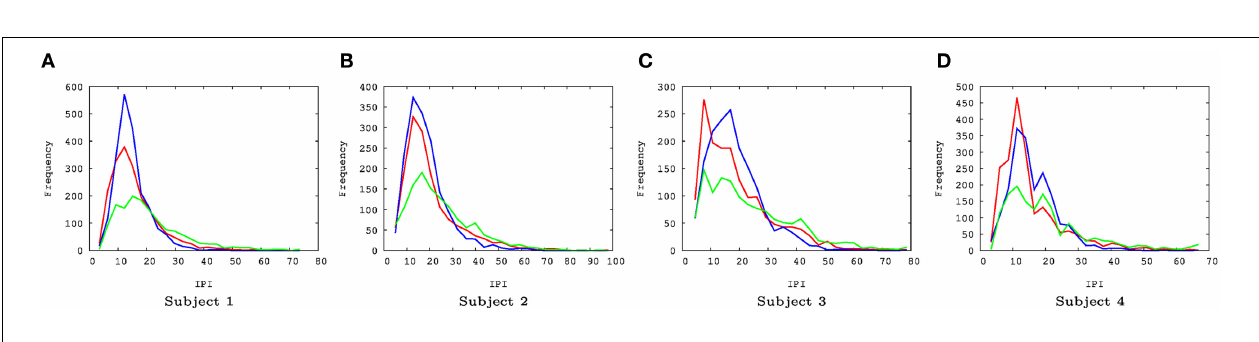
skewness varied from 0.83 to 2.71. The x -axis represents time (unit = 10ms) and the y -axis frequency. (A) Subject 1, (B) subject 2, (C) subject 3, (D) subject